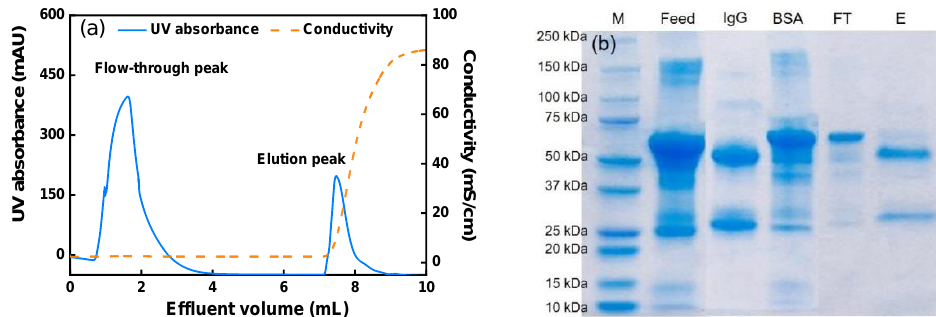
Figure 7. ( a ) The chromatogram of IgG separation from IgG/BSA mixture at 0.24 mL/min flow rate using 12 membrane